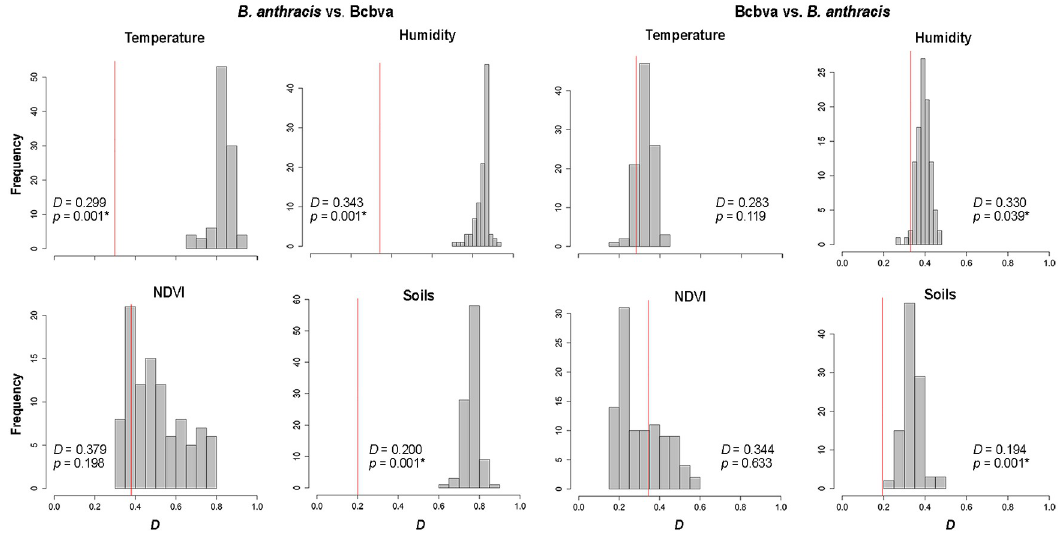
Fig 5. Background similarity tests between Bacillus anthracis and Bcbva for each individual environmental dimension. Comparisons were performed using three principal components for each environment, namely temperature, humidity, NDVI, and soils for B . anthracis vs. Bcbva (left) and Bcbva vs. B . anthracis (right). Significant p -values (asterisk) indicate less similarity than expected when comparing to a random